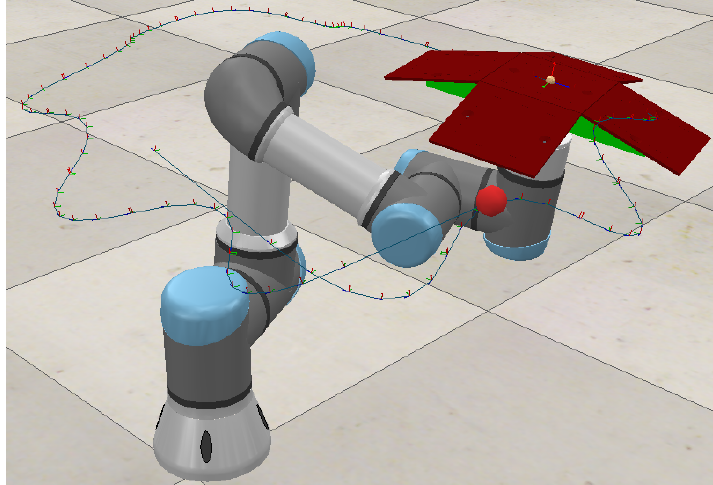
Figure 2. Simulated path of the UR3 in CoppeliaSim, simulation